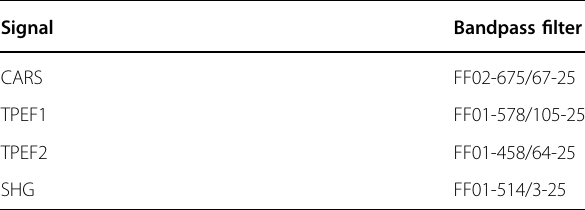
Table 2 list of bandbass fi lters for selection of the non- linear signals, all fi lters are from Semrock,